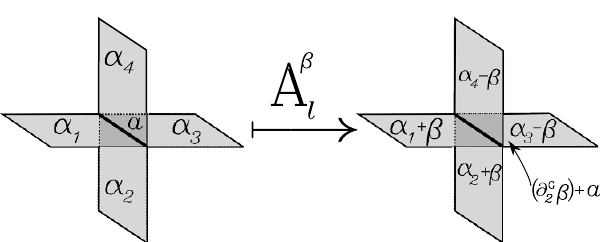
Figure 1 . The action of A (cid:12) is shown on an initial arbitrary basis state, involving the link l 2 K 1 l and its four adjacent